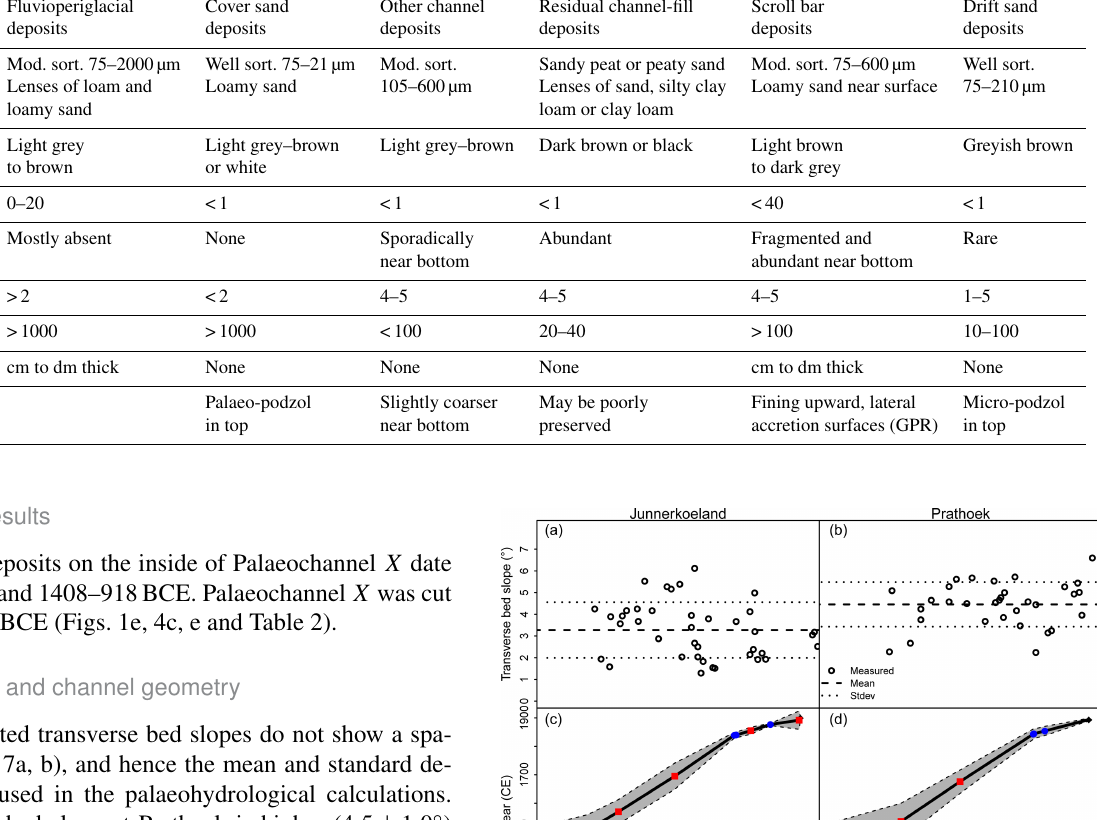
Table 1. Description of lithogenic units. Fluvioperiglacial